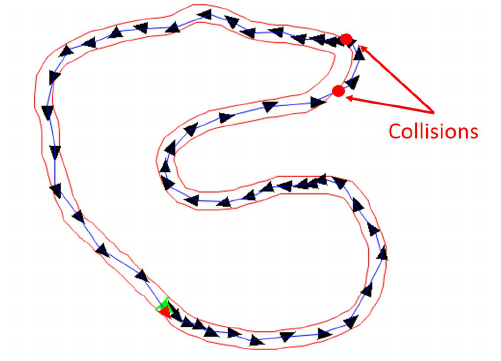
Figure 7. An example of a simulated route with collisions.